Question: Name the type of graph shown.
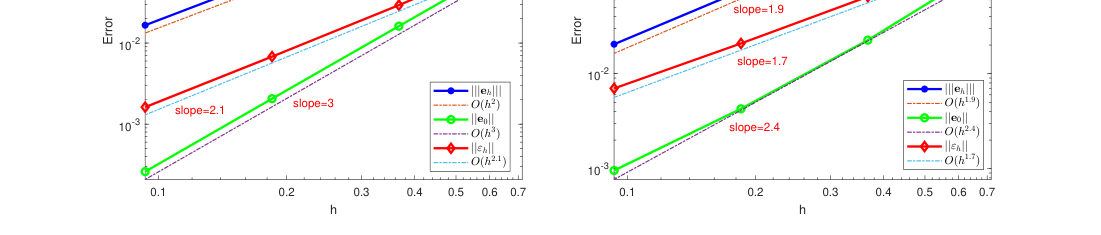
Answer: line